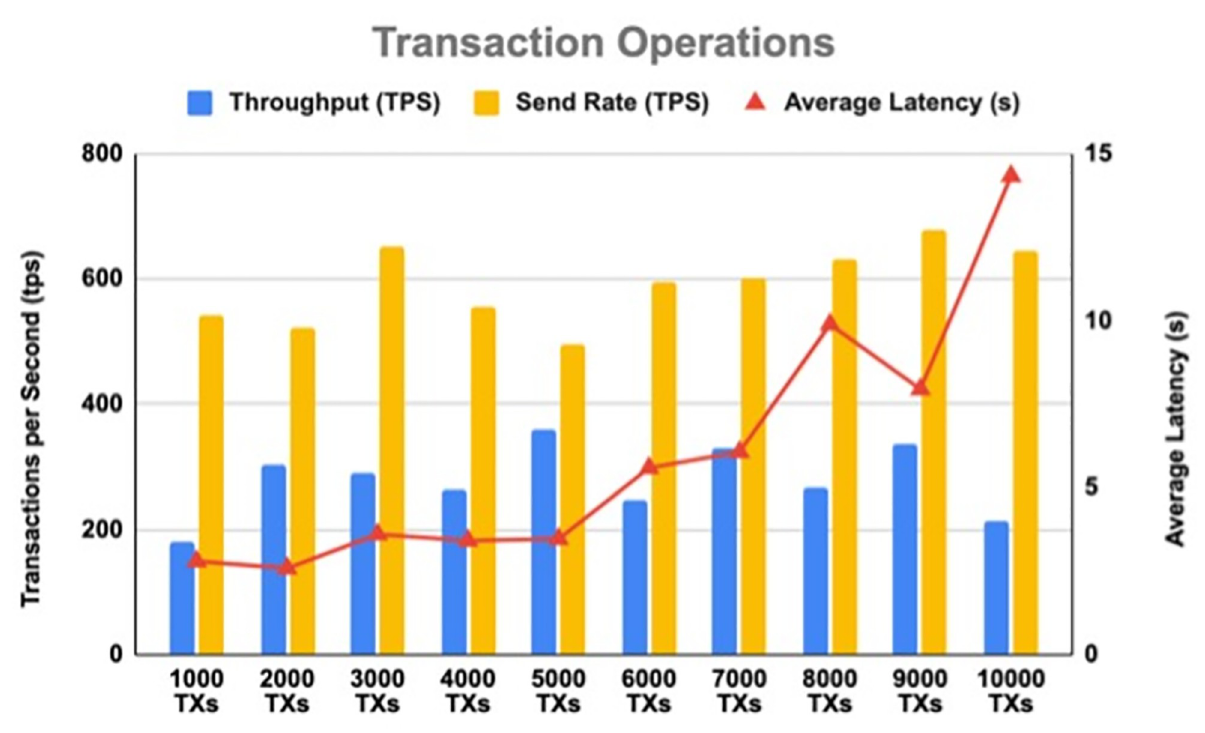
Fig 11. The impact of the increasing number of transactions on throughput and latency for Transaction operations.